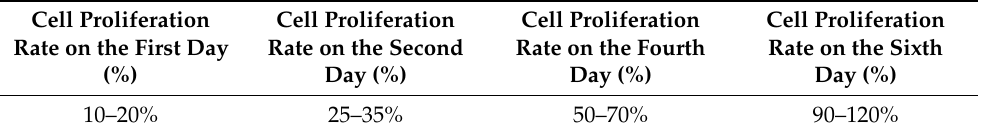
Table 5. The cell proliferation rate in different periods.